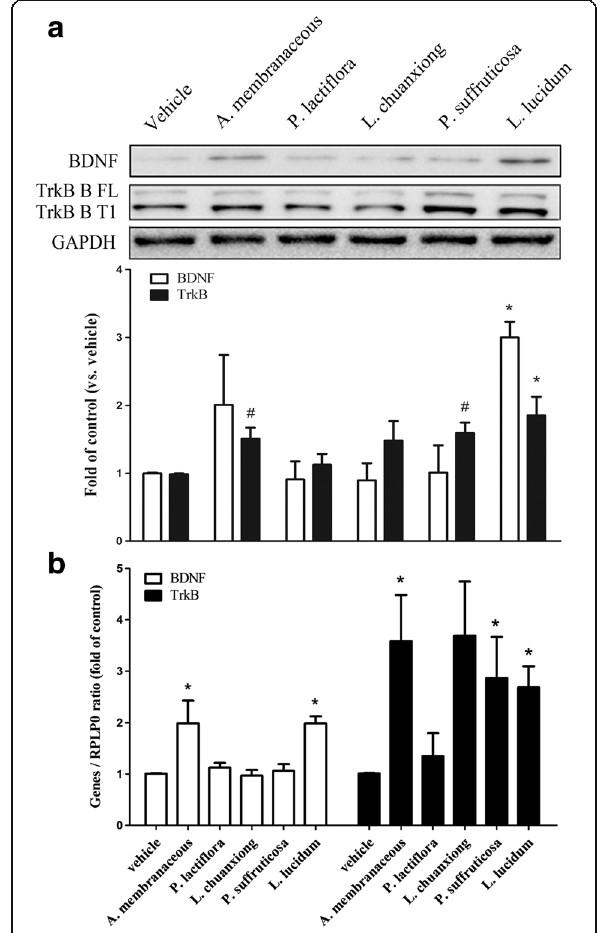
Fig. 7 The effects of various Chinese herbal extracts (CHE) on the gene expression within the BDNF autoregulation loop using HUVECs. Cultured HUVEC cells with/without/with a given CHE (1 μ g/ mL for each herbal extract) pretreatment were lysed and the protein and mRNA gene expression levels of BDNF and TrkB were analyzed by Western blot ( a ) and real-time PCR ( b ), respectively. Data are expressed as mean + SEM. *, p < 0.05 compared to vehicle group by repeatedly measured one way ANOVA; #, p < 0.05 compared to ve- hicle group by Student ’ s t test (n = three to five independent experi- ments for each